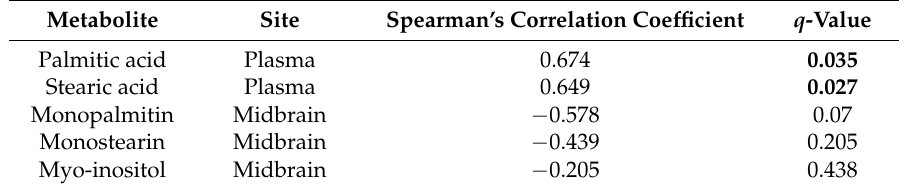
Table 1. Summary of correlation results of plasma and midbrain metabolites with the cylinder